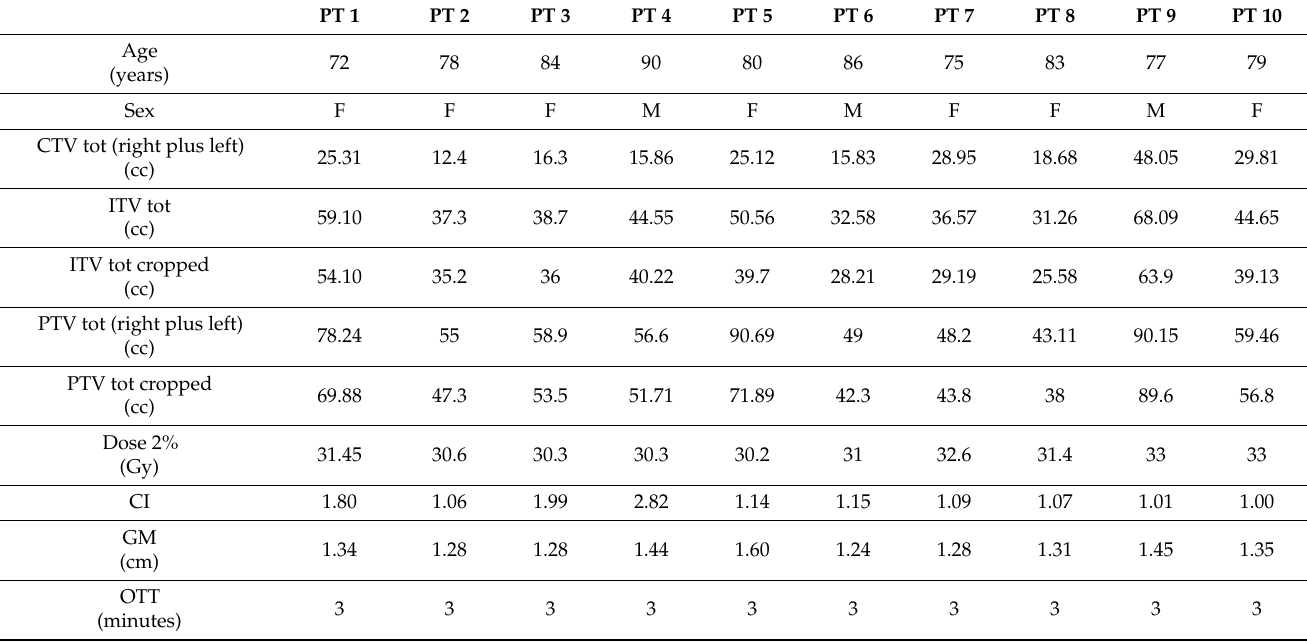
Table 1. Main treatment planning and dosimetric data.